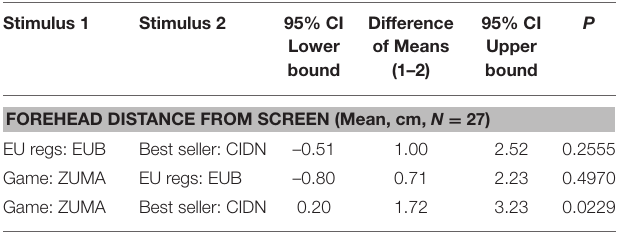
TABLE 12 | Comparison of mean distance to the screen during each interactive stimulus. Stimulus 1 Stimulus 2